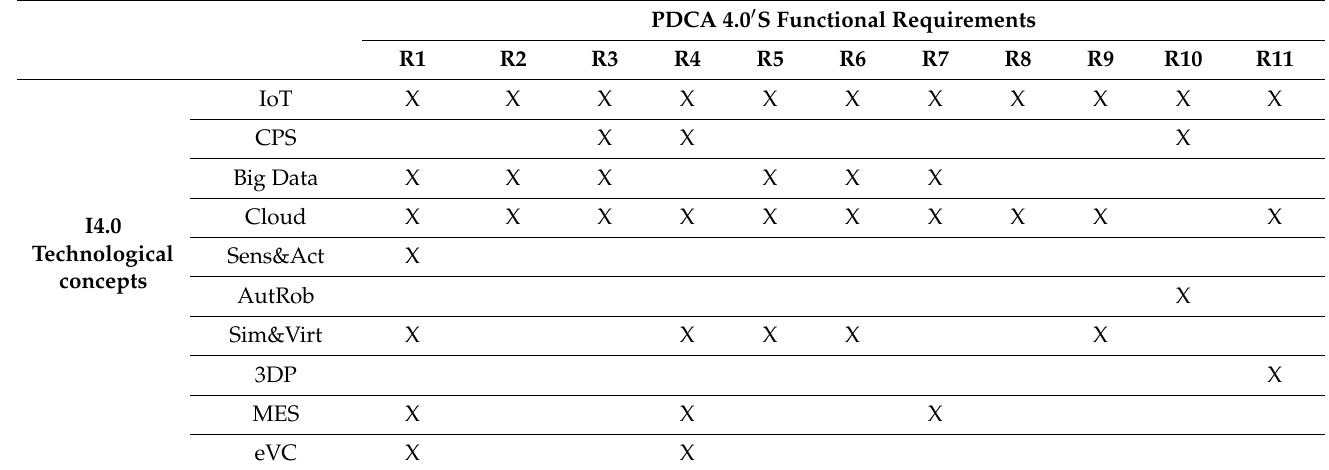
Table 3. Technological concepts for PDCA 4.0 (cid:48) s functional